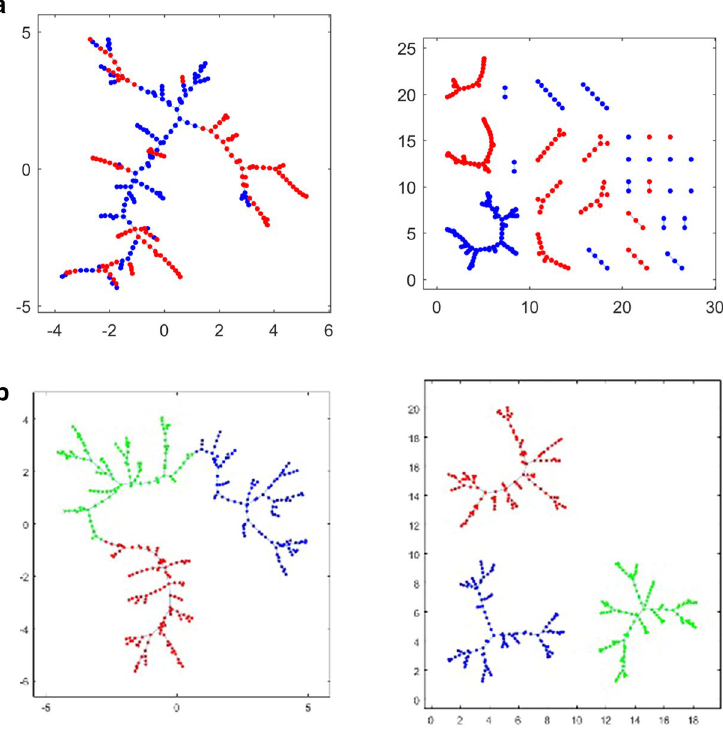
Figure 3. Illustrations of the multivariate-runs (MVR) MST-cutting procedure. The nodes for different disease classes are pooled, yielding and MST composed of a mixture of class characteristics (left panels). The MST edges between dissimilar node-classes are then removed, yielding disjoint subtrees (right panels). The test statistic is the number of trees produced; in general the fewer the subtrees, the less probable is the null hypothesis. ( a ) Presents an example with the classic 2-class test; ( b ) Shows results from pooling all three disease